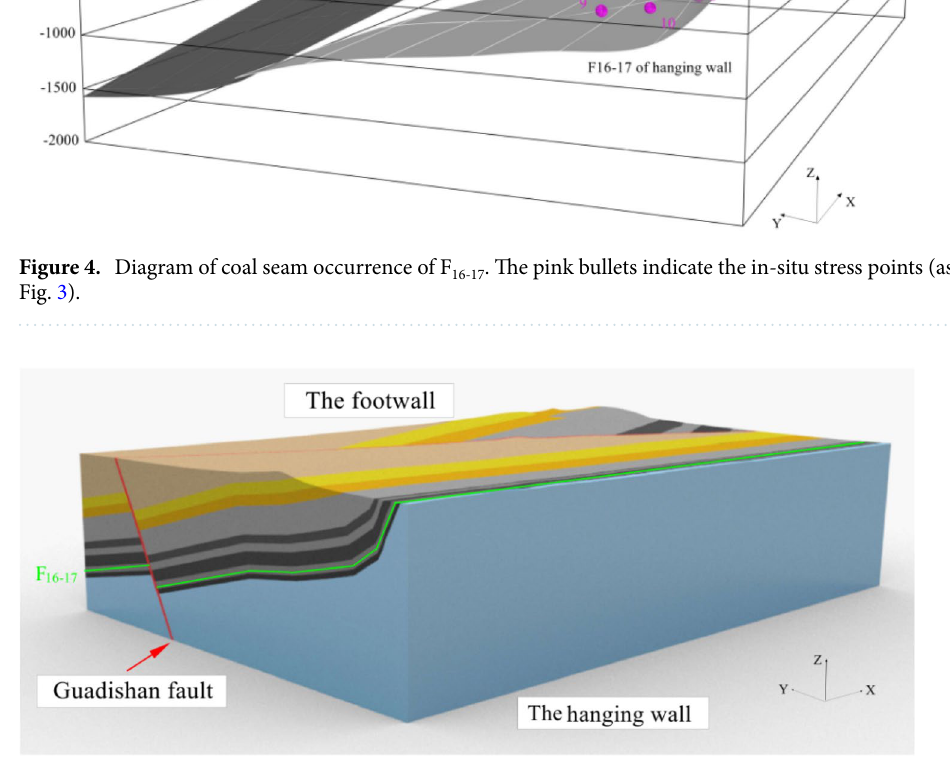
Figure 5. 3D geological model of Guodishan fault